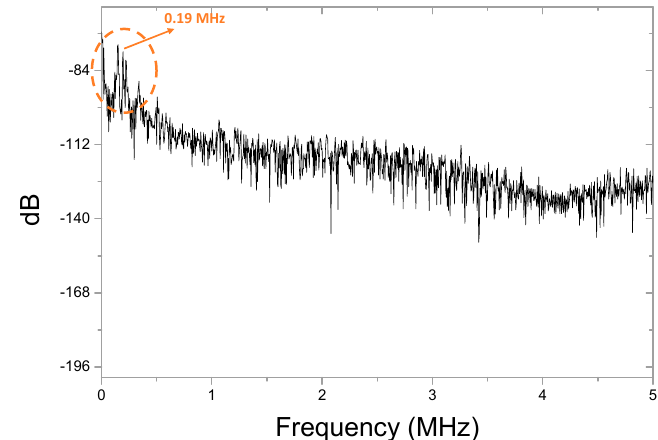
Figure 7. The frequency domain of the signal from the FP fiber sensor (10 mm distance test).